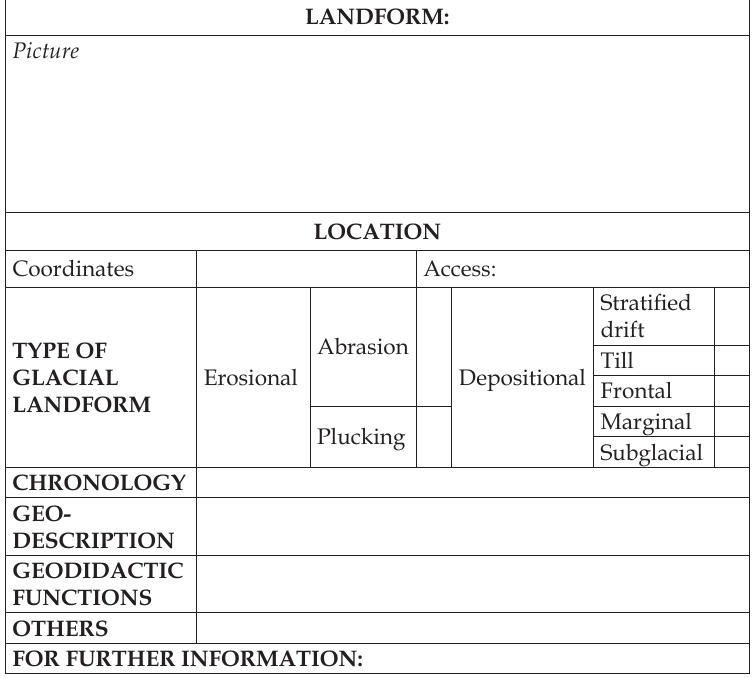
Table 1. Datasheet designed to collect information about each glacial landform.